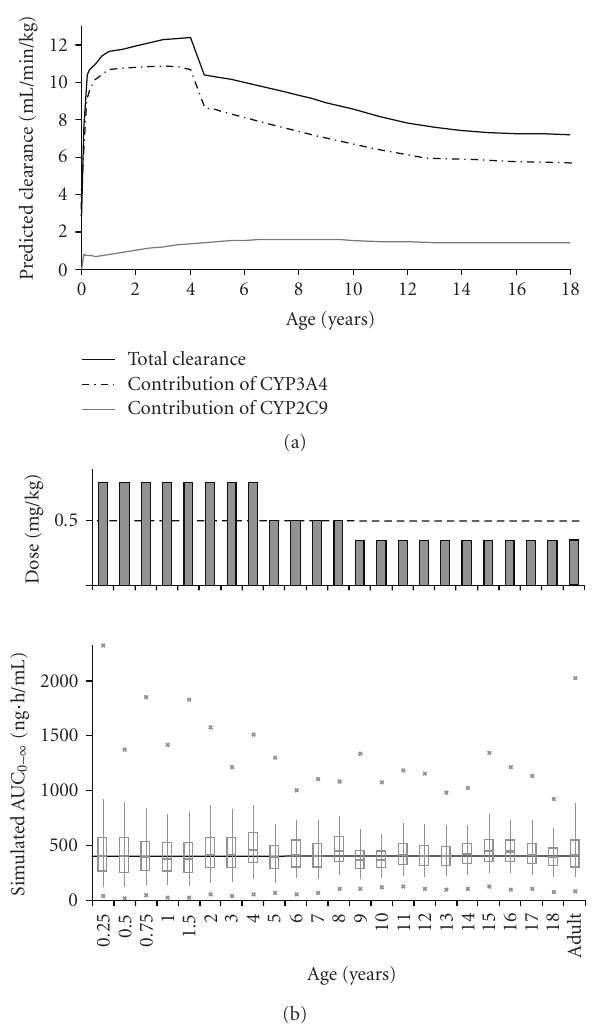
Figure 7: Simulation results using the PK-Sim software of a PBPK model for sildenafil in children [53]. (a): Predicted age-dependent sildenafil hepatic clearance across di ff erent pediatric ages based on the clearance scaling module in PK-Sim software. (b): Age-related doses for oral sildenafil in children depending on the simulated age-related exposure (not shown) of sildenafil in a virtual pediatric population and the estimated exposure of the estimated doses of sildenafil in children between 3 months and 18 years. Potential pediatric doses based on simulations for sildenafil to achieve adult exposure: infants and children from 3 months to 4 years: 0.8mg/kg; children from 5 to 8 years: 0.5mg/kg; and children older than 8 years: 0.35mg/kg as in adults. Box plots represent median, 25th, and 75th percentiles (box), 5th and 95th percentiles (error bar), and maximum and minimum values ( x ) of AUC 0 −∞ from 1000 simulations in each age group.